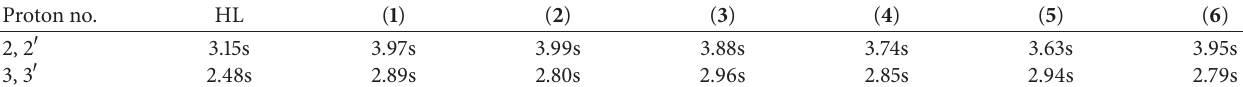
Table 3: 1 H NMR data a–d (ppm) of heterobimetallic complexes with sarcosine. Proton no.